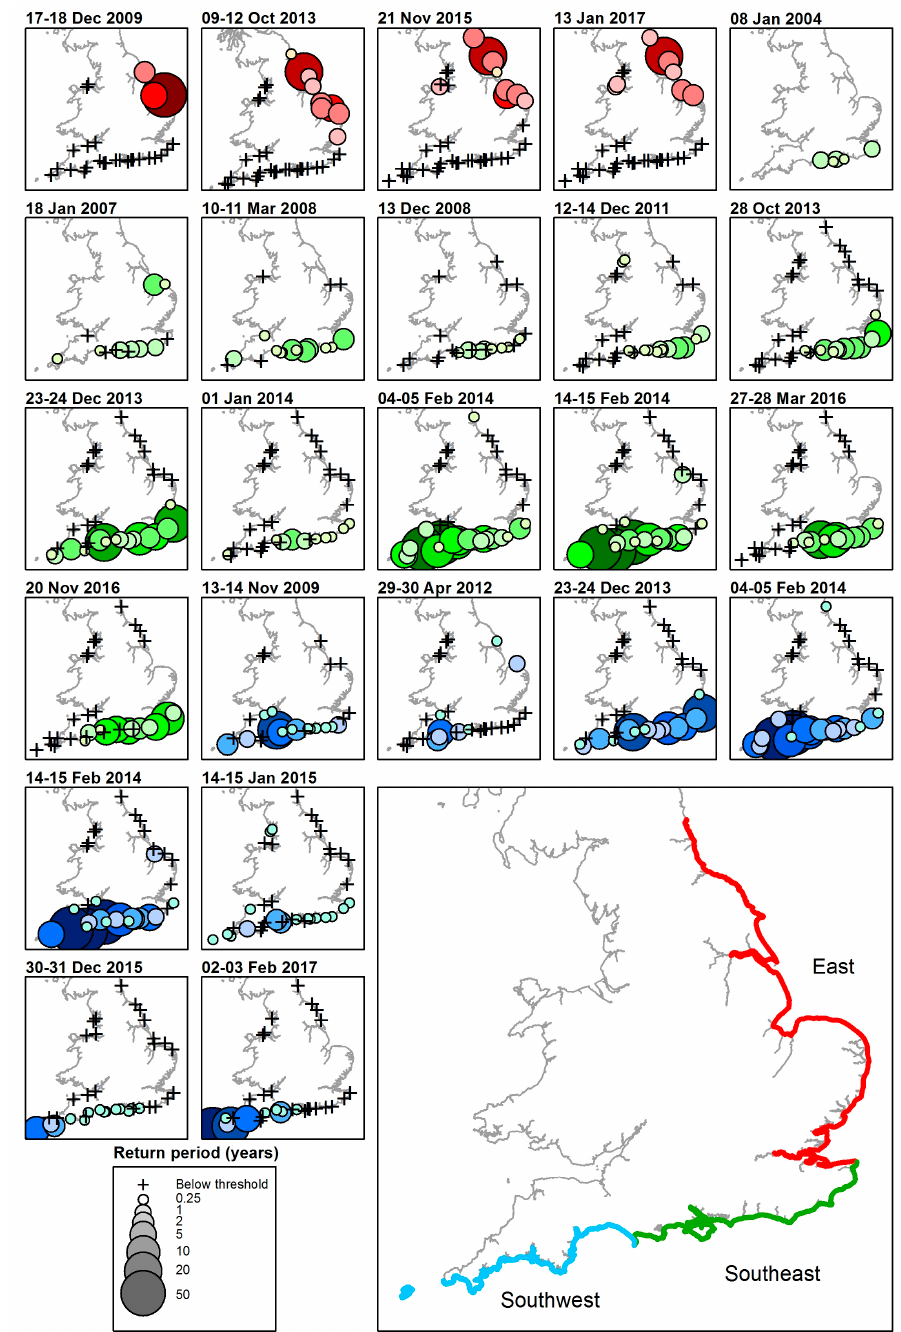
Figure 3. Spatial footprints of extreme wave events affecting at least three sites in the East, Southeast, and Southwest areas.